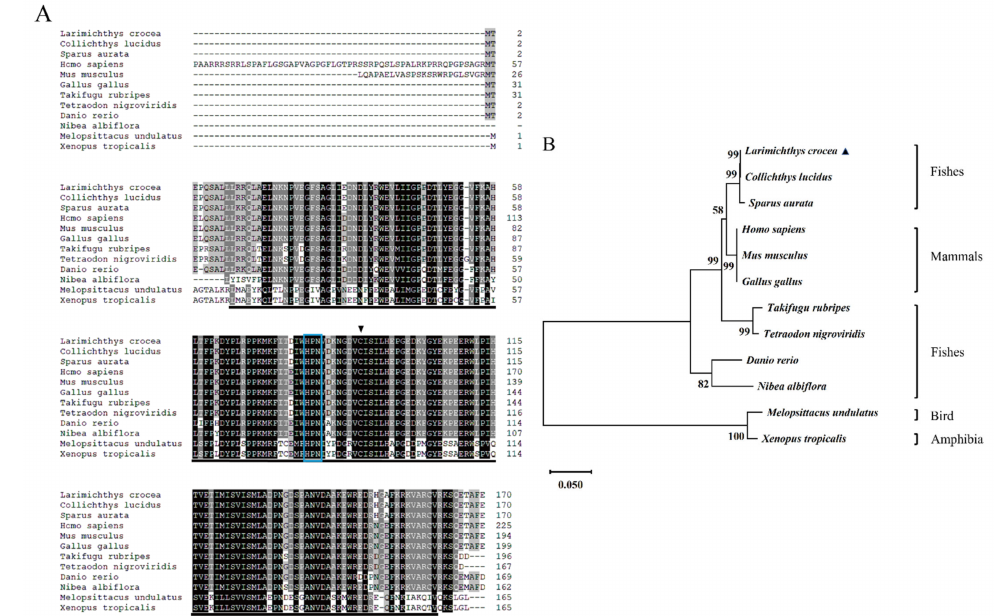
Figure 2. Sequence alignment and phylogenetic analysis of LcUbe2g1 and its homologs. ( A ) Multiple sequence alignment of LcUbe2g1 and its homologs. The blue boxes indicate the ubiquitin (Ub) binding motifs (HPN), the black triangle indicates the active site cysteine (C), the black shading and gray shading indicate the amino acid sequence similarity of 100% and 80%, respectively, and the GenBank accession numbers of amino acid sequences of the species used are detailed in Table 1; ( B ) Phylogenetic analysis of LcUbe2g1 and its homologs. The number at each node indicates the percentage of bootstrapping after 1000 replications. Scale bar refers to evolutionary distance of 0.05 million